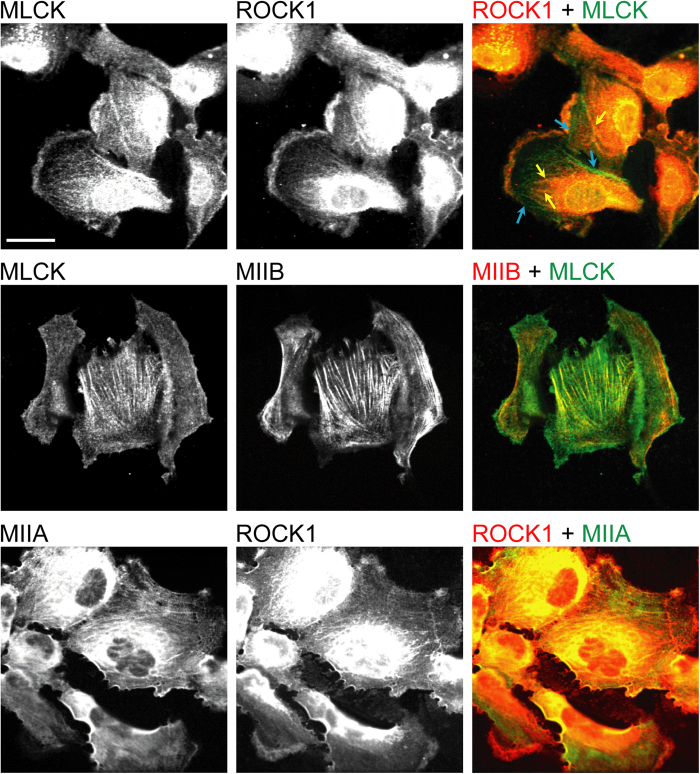
Immunofluorescence confocal optical section images illustrating colocalization of MLCK and MIIB, and of ROCK1 and MIIA.(Top row) Co-staining of ROCK1 and MLCK. Yellow arrows indicate ROCK1-associated central SFs, and light blue arrows indicate MLCK-associated peripheral SFs. (Middle row) Co-staining of MIIB and MLCK. (Bottom row) Co-staining of MIIA and ROCK1. In the top and bottom rows, the image brightness was adjusted to more clearly depict stress fibers in the lamellar regions of the cell, thus necessitating saturation at the cell center. Scale bar: 30 μm.